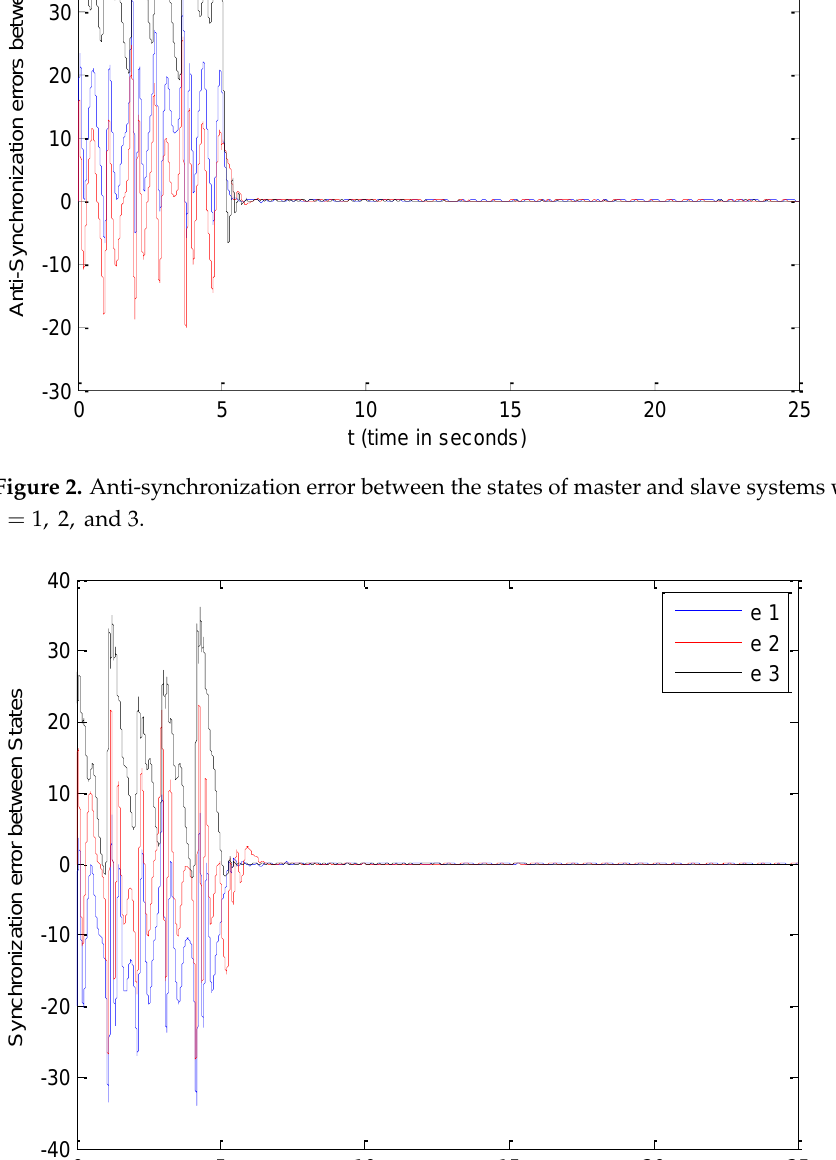
Figure 3. Fractional order derivative with α = 0.9, α = 0.8 and α = 0.5, time delay τ = 5 s. Time-delay synchronization errors between the states of master and slave systems.